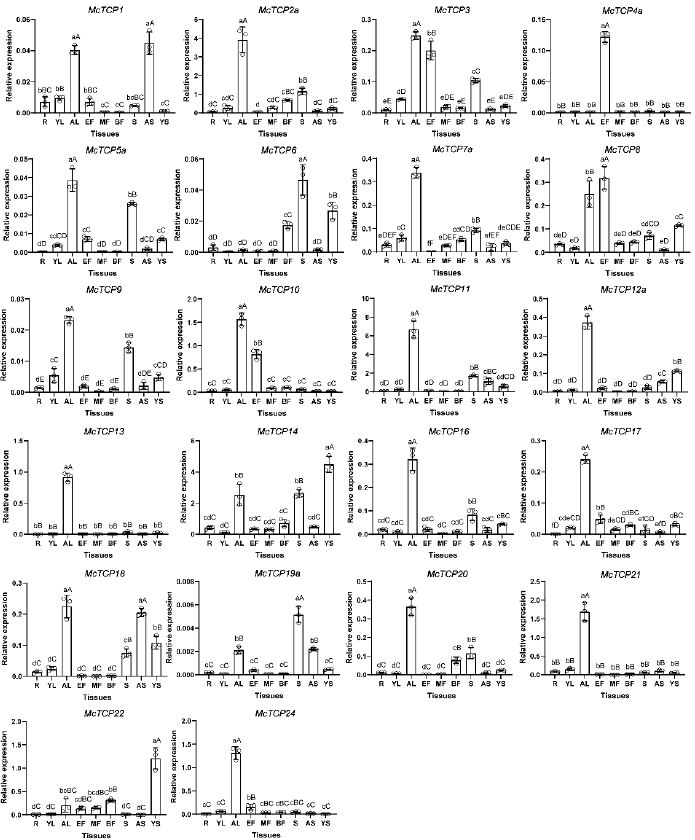
Figure 10. Expression analysis of TCP- family genes in nine tissues by qRT-PCR. YL: young leaves; AL: adult leaves; YS: young stems; AS: adult stems; S: seeds; R: roots; EF: early-stage flowers; MF: middle-stage flowers; BF: blooming flowers. Hollow circles in these graphs represent the relative expression of three biological repeats. The relative expression levels are shown as the means ± SDs. Duncan’s test was used to evaluate significant difference levels. Lowercase letters mean p ≤ 0.05, capital letters mean p ≤